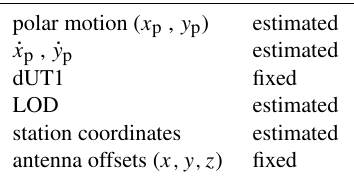
Table 3. Fixed and estimated parameters within ESA’s GNSS Final